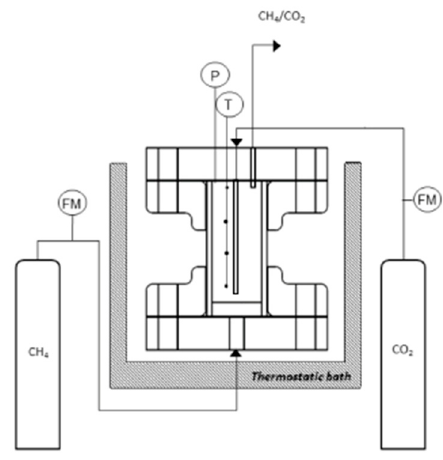
Figure 3. Schematization of the completely assembled experimental apparatus.